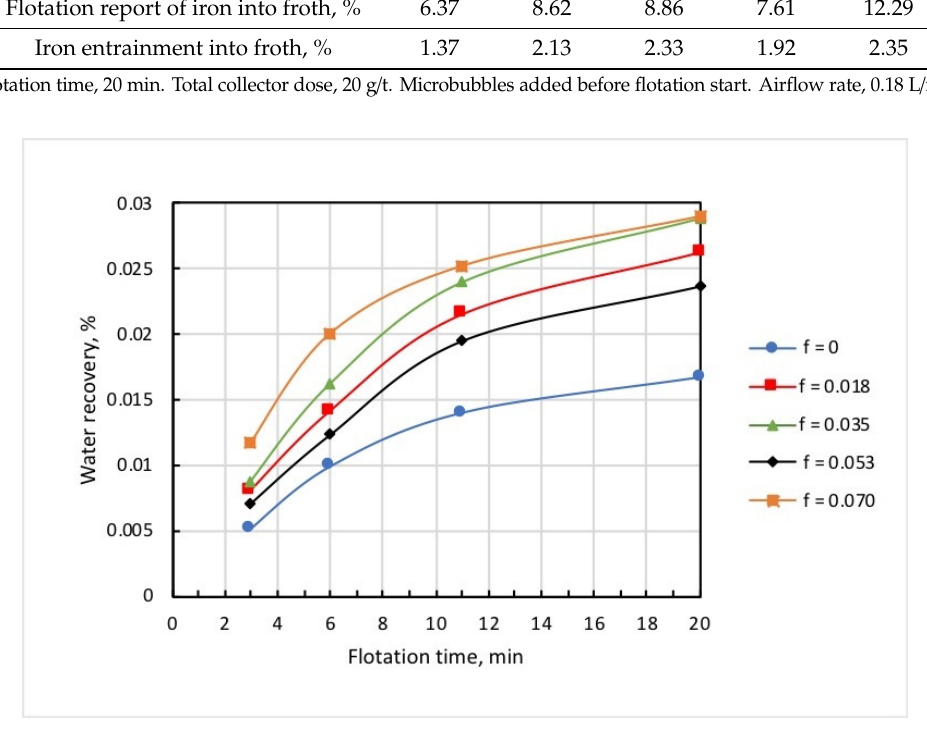
Figure 11. Kinetics of water recovery at different doses of microbubbles f (mL/g).